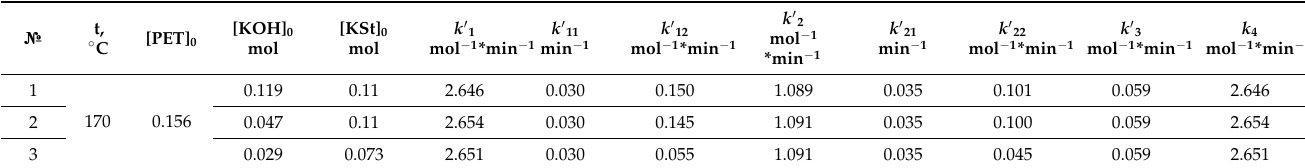
Table 5. Parameters of Equations (3)–(14) according to Equations (15)–(21) for different initial potassium